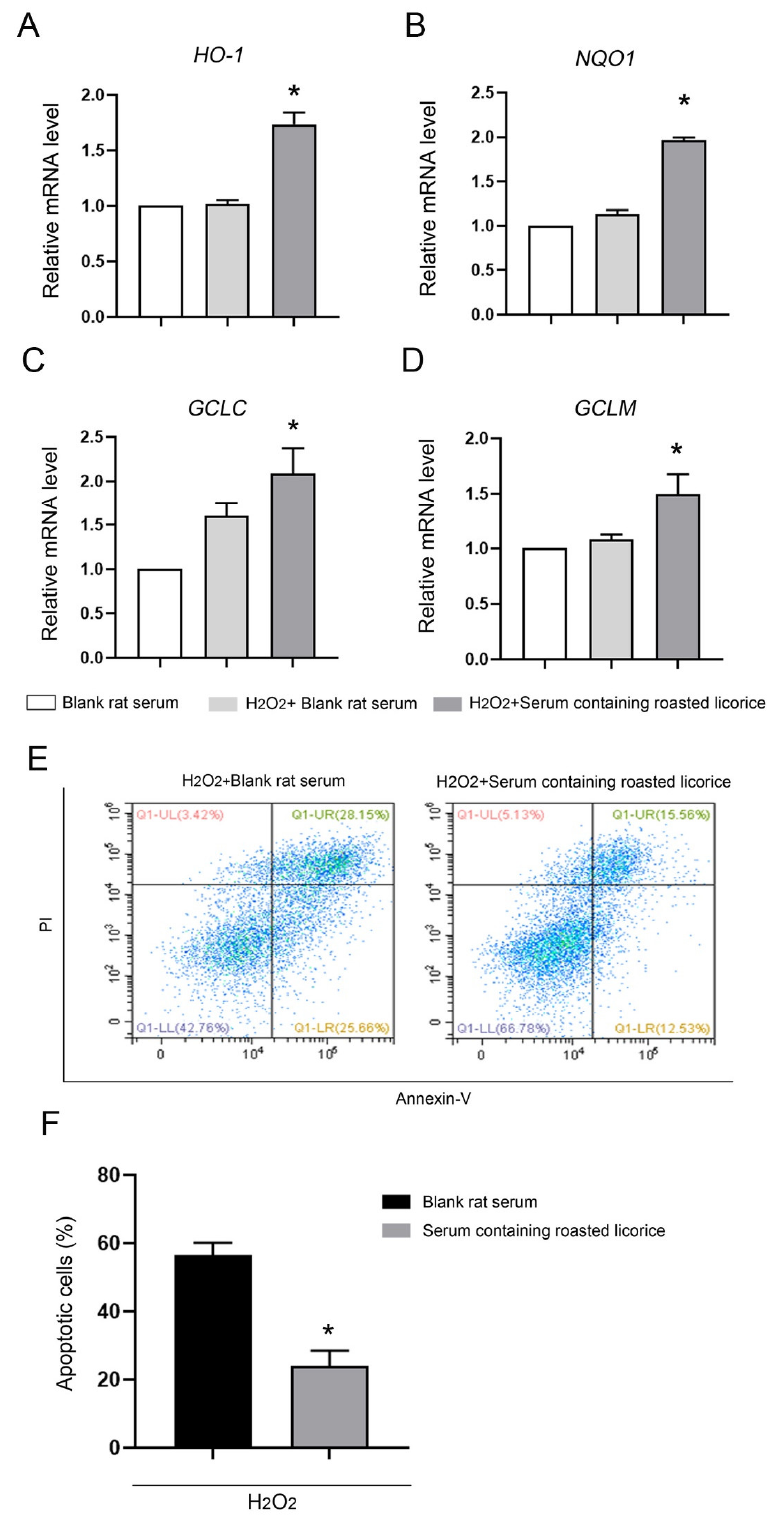
Figure 3. The antioxidant activity of roasted licorice extracts in vitro Transcriptional alteration of gene in Caco-2 cells: ( E ) Representative flowcharts showing that cell apoptosis was determined by flow cytometric analysis in Caco-2 cells with different treatments. Cells were stained with fluorescein isothiocyanate (FITC)-conjugated Annexin V and propidium iodide (PI); ( F ) quantification of the percentage of apoptotic cells. * Significant difference as compared with the H 2 O 2 combined with blank rat serum treatment group, p < 0.05. Data were obtained from three independent